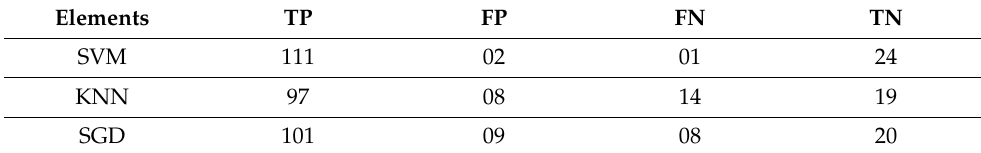
Table 7. Elements of Confusion Matrix.